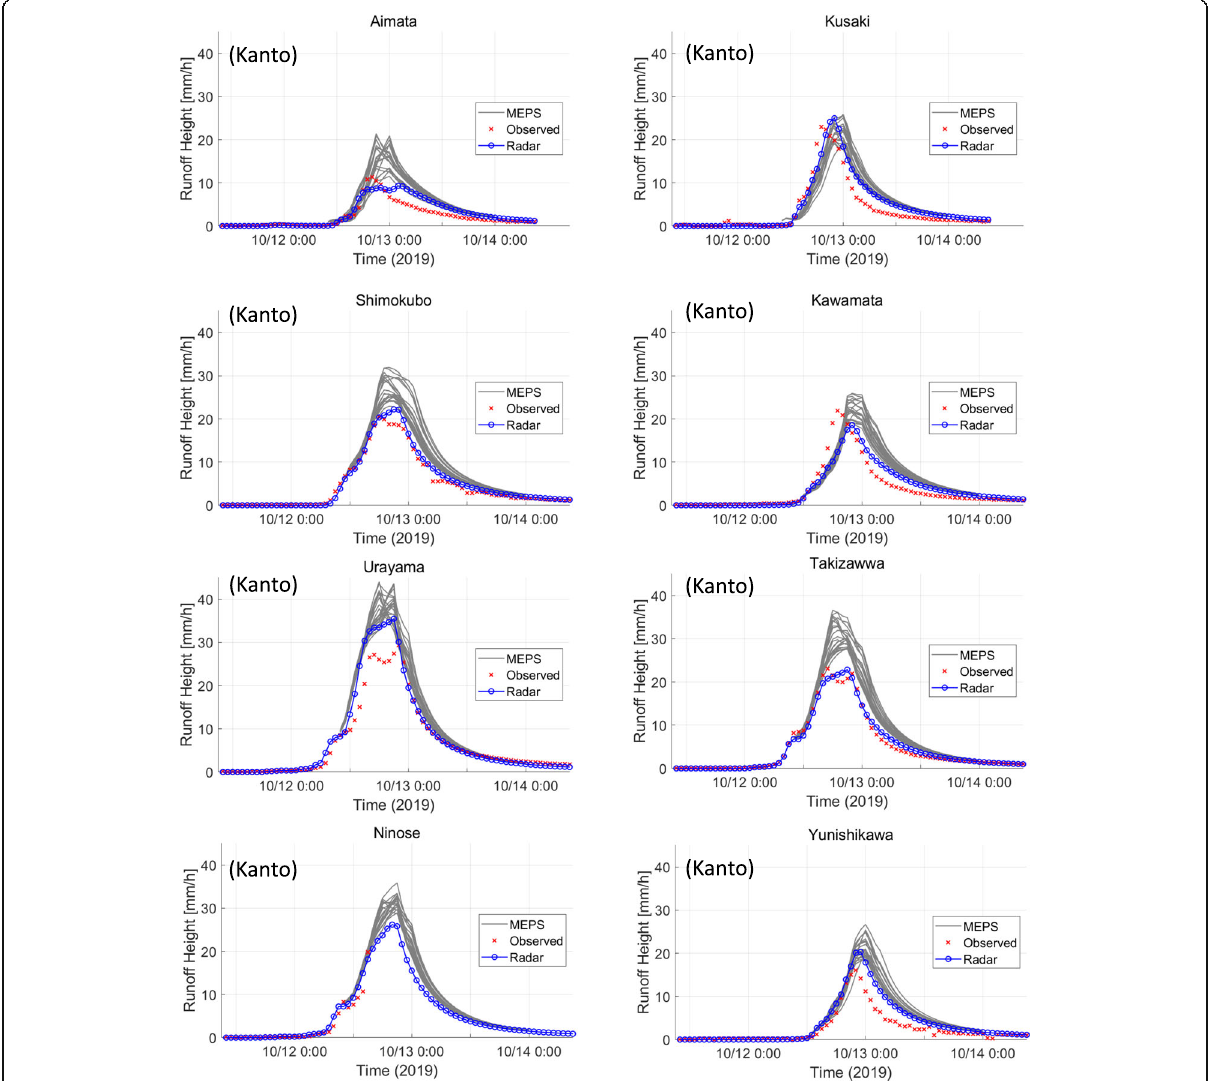
Fig. 3 Observed and simulated hydrographs at dam reservoirs for T19 (calibrated case). The “ radar ” shows the simulated hydrographs, and “ MEPS ” shows the forecasted results initialized at 9:00 on 11 October 2019 by 21 ensemble members. These dams are positioned in the Kanto